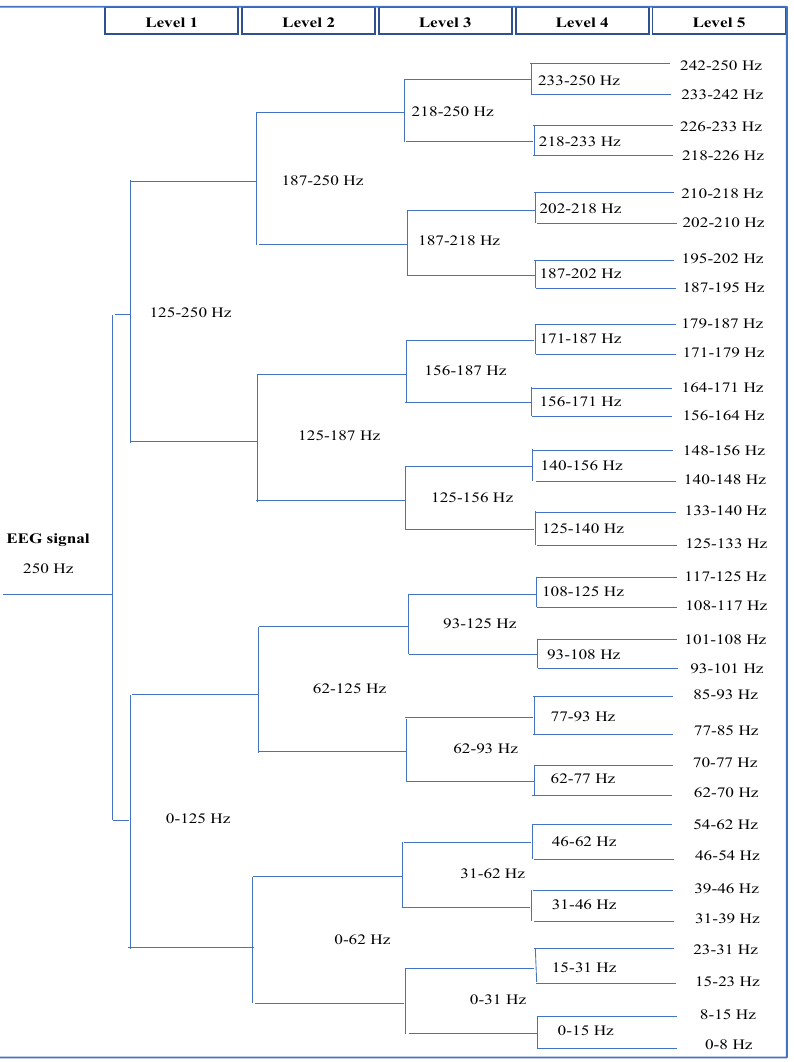
Figure 4. Five level EEG signal decomposition using WPD.